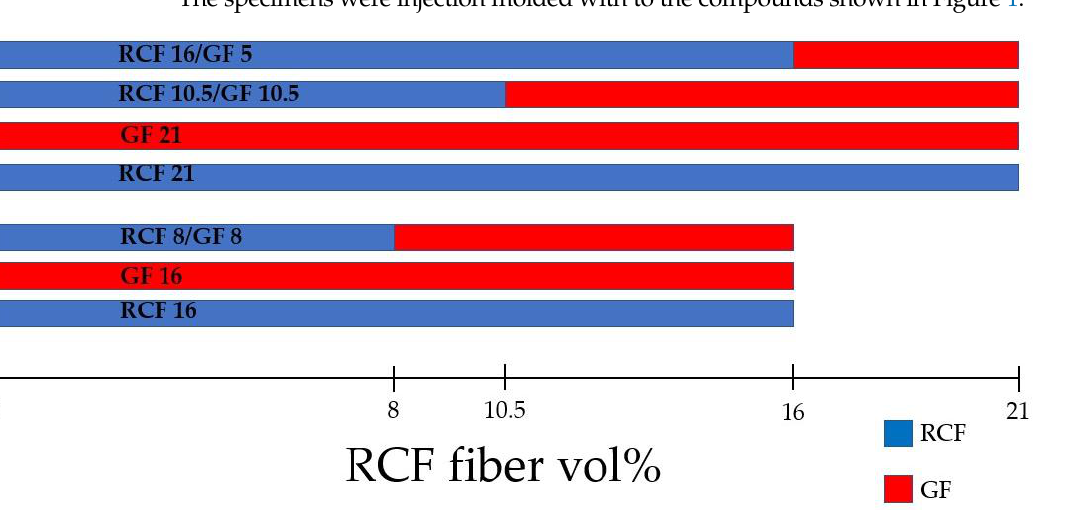
Table 2. Temperature setting along cylinder of double screw extruder.